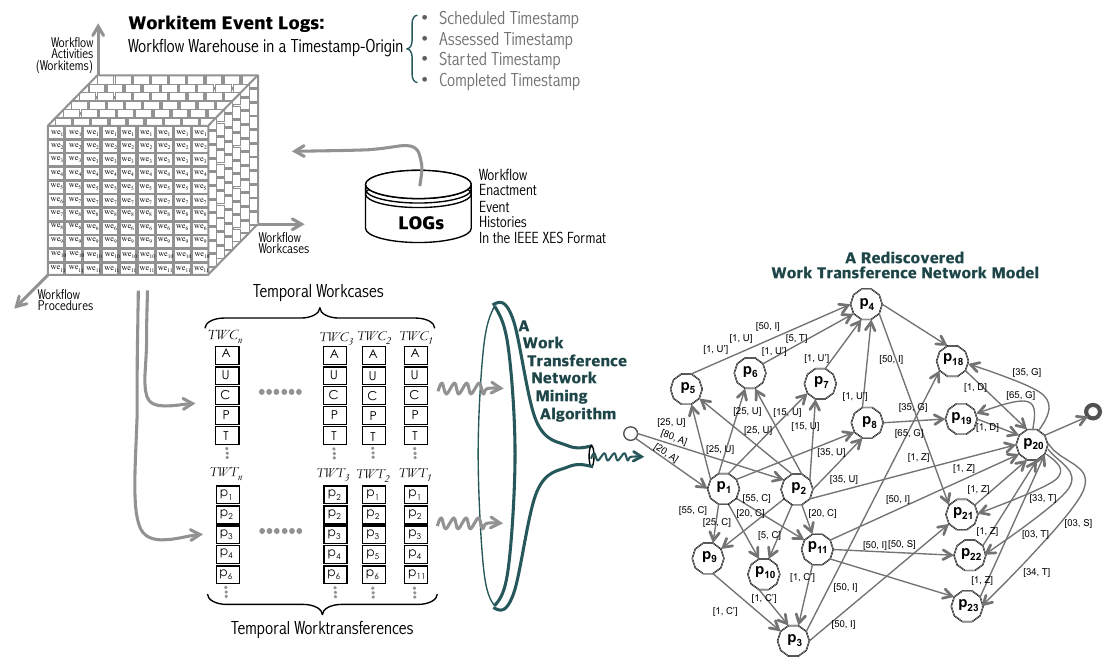
Figure 2. Conceptual discovery